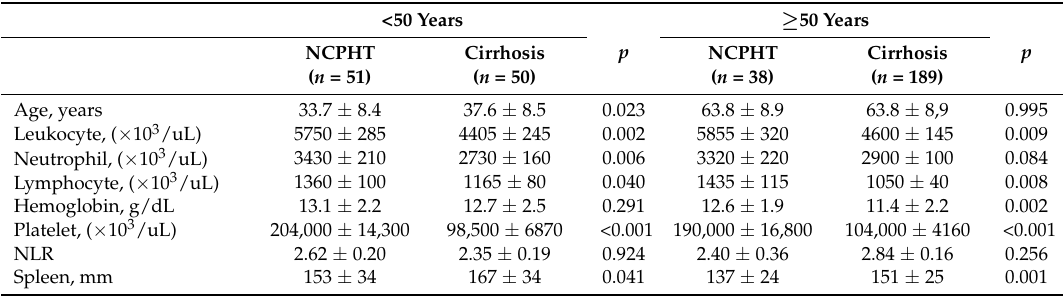
Table 3. The comparison of hematological indices in subgroups of patients with cirrhosis and patients with NCPHT by age